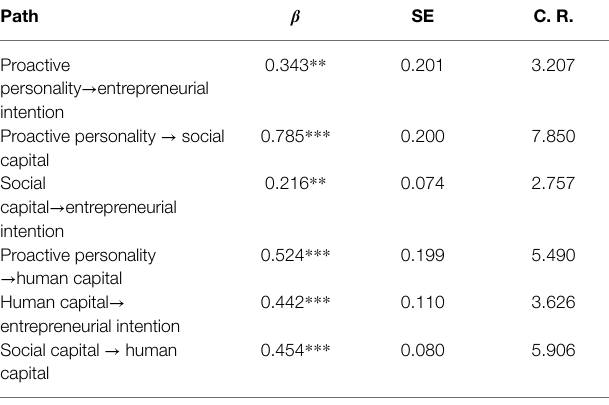
TABLE 4 | SEM analysis results. Path β SE C. R.